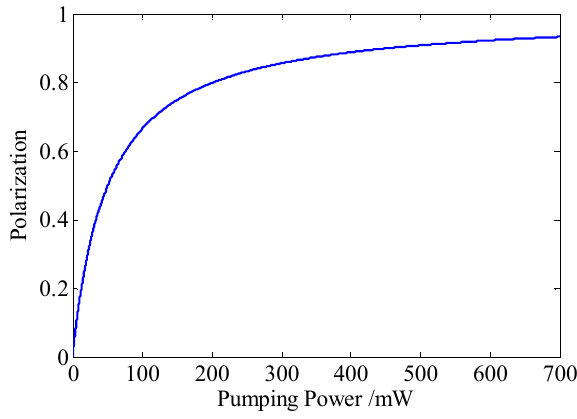
Figure 6. Relationship between the pumping power and the polarization.